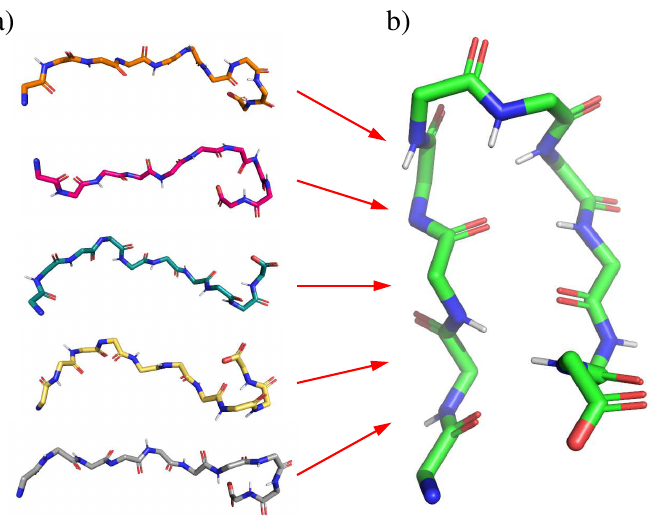
Figure 2. Structural representation of Chignolin. ( a ) A set of extended conformations involving the initial turn at the C-terminal side. ( b ) Folded conformation. Only the protein backbone is represented, using PyMOL [39]. Table 2. Performance indicators of the HDFS algorithm to compute different conformational transitions of Chignolin (top) and the mutant Chignolin-W9A (bottom). CPU time was measured